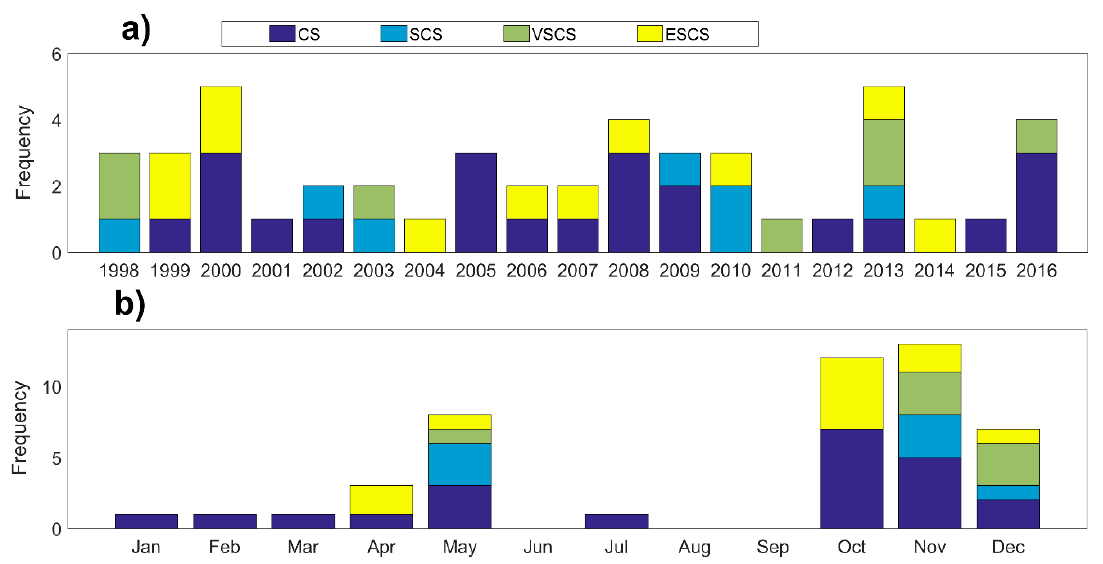
Figure 1. ( a ) Yearly, ( b ) monthly distribution of Tropical Cyclones (TCs) in the Bay of Bengal (BoB) during 1998–2016.